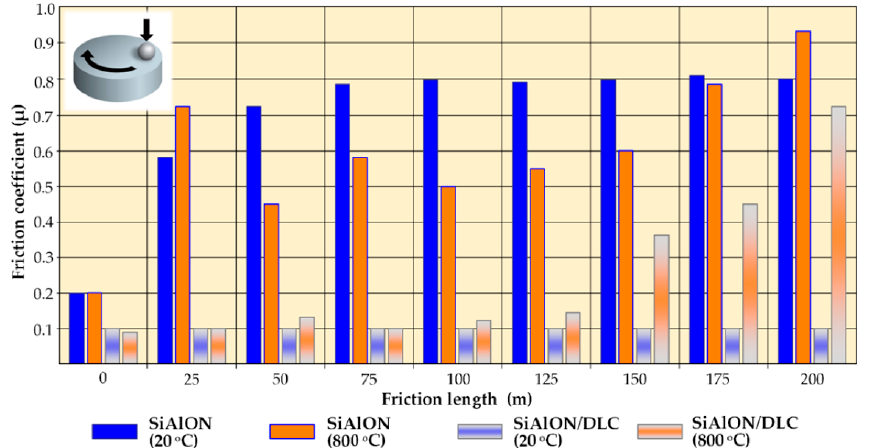
Figure 15. Dependences of the friction coefficient on the surface of experimental specimens made of SiAlON (80% (90 α 10 β ) + 20% TiN) ceramics on the friction path before and after DLC coating deposition under various test temperature conditions: without heating (20 °C) and with heating to 800 ° С .